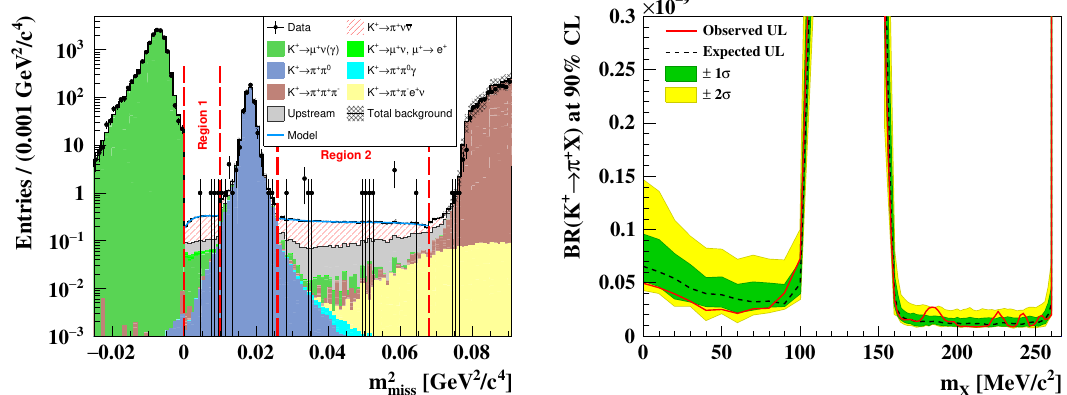
miss hypothesis, as X